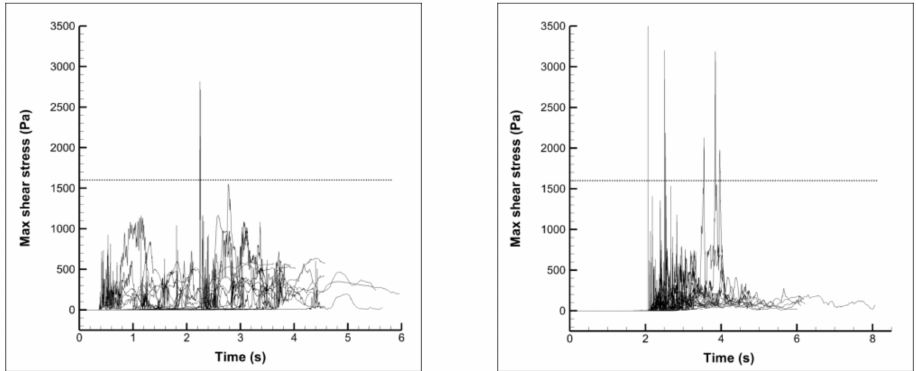
Figure 14. Maximum shear stress history for different tracks at turbine mode ( left ) and pump mode ( right ). The dotted horizontal line represents the minor injury threshold of 1600